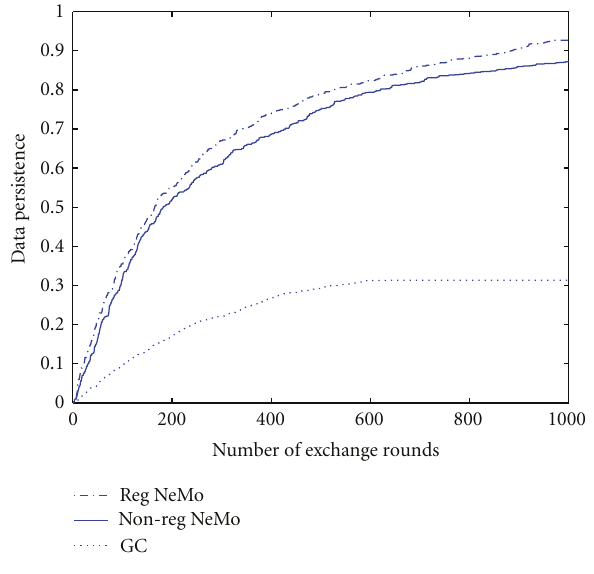
Figure 10: Average persistence from experiments. Table 3: CPU time (in